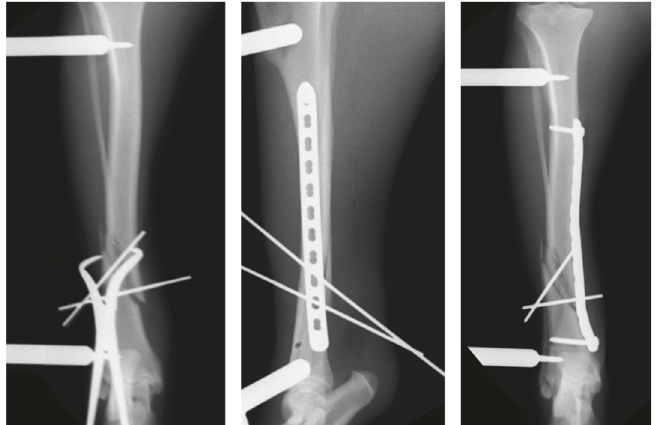
Figure 5: Intraoperative fluoroscopic images demonstrating the use of percutaneous point-to-point reduction forceps and interfragmentary Kirschner wires to maintain temporary fracture stabilization prior to plate